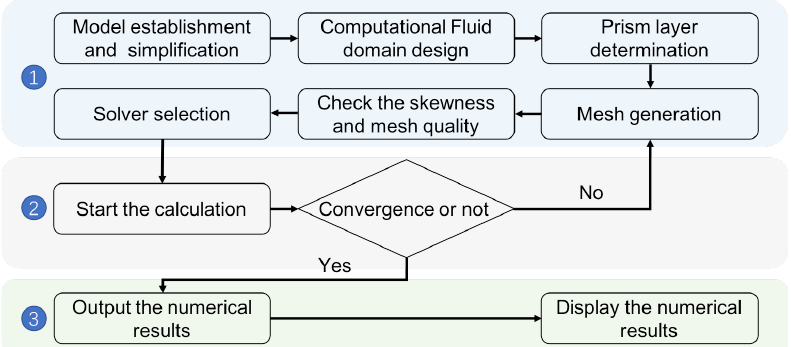
Figure 4. Procedure of numerical study on hydrodynamic coefficient estimation of the underactuated underwater vehicle.